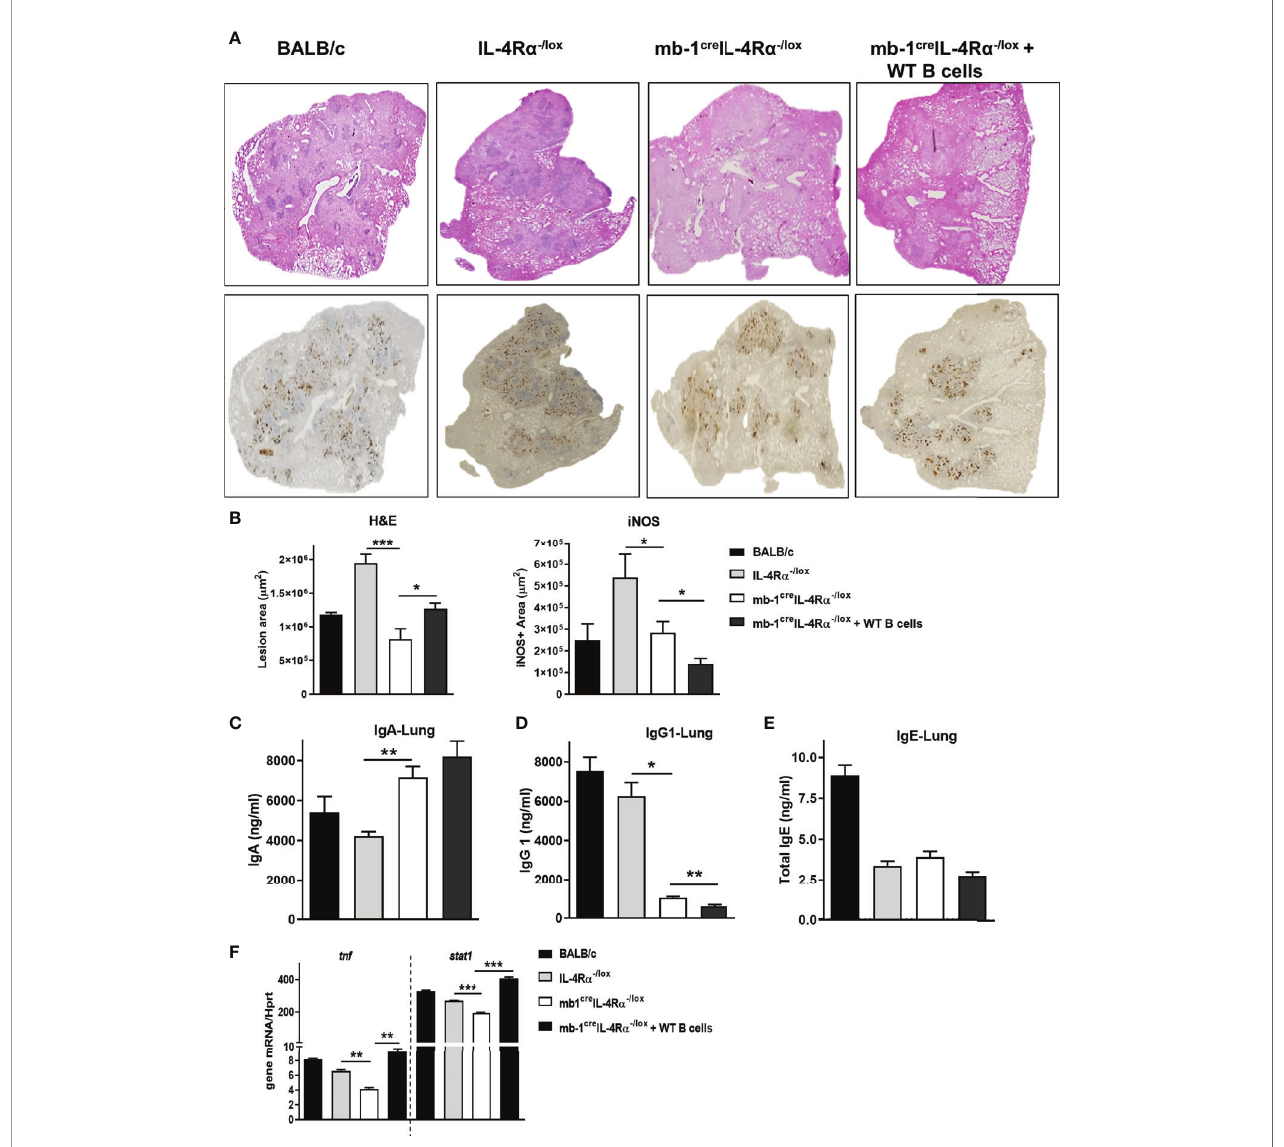
FIGURE 3 | Adoptive transfer of WT B cells in the lungs restored the pulmonary pathology in B cell-speci fi c IL-4R a de fi cient mice during Mtb infection. Formalin- fi xed lung samples were stained for the H&E and iNOS expression after 18 weeks post-infection. (A) Representative histology images from all the groups and (B) quanti fi cation of lesions area and iNOS positive staining in the lungs (Original magni fi cation: 2X). Antibody responses in the lungs of mice. (C) IgA, (D) IgG1 and (E) total IgE production in the lungs after 18 weeks of infection. (F) Tnf and Stat1 mRNA expression in fl ow-sorted B cells (CD3 - CD19 + B220 + ) after 18 weeks of Mtb infection. Data are shown as mean ± SEM of n = 5 mice/group, representative of two independent experiments, analysed by unpaired, student t-test versus littermate control, *p < 0.05, **p < 0.01 and ***p <